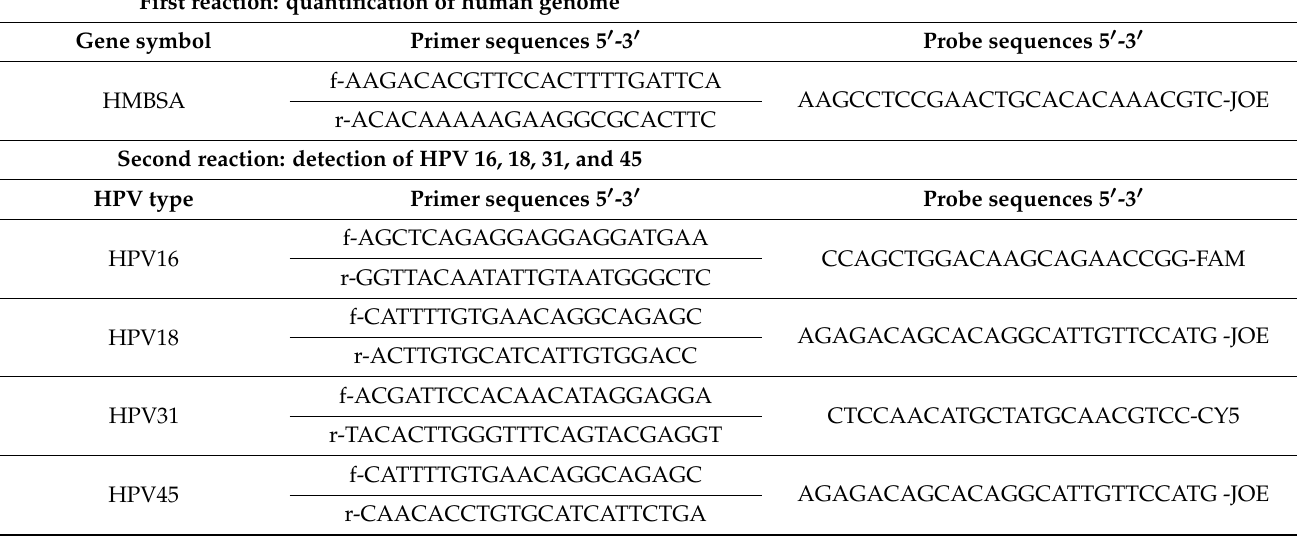
Table 1. Primer and probe